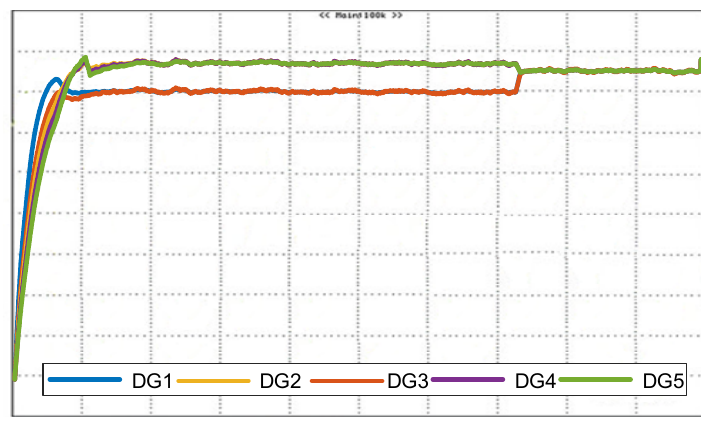
(f) Experimental results of reactive power rate of five DGs after type (c) failure for 2 s duration Figure 21. Experimental results of three kinds of communication failures with di ff erent Figure 21 . Experimental results of three kinds of communication failures with different durations.